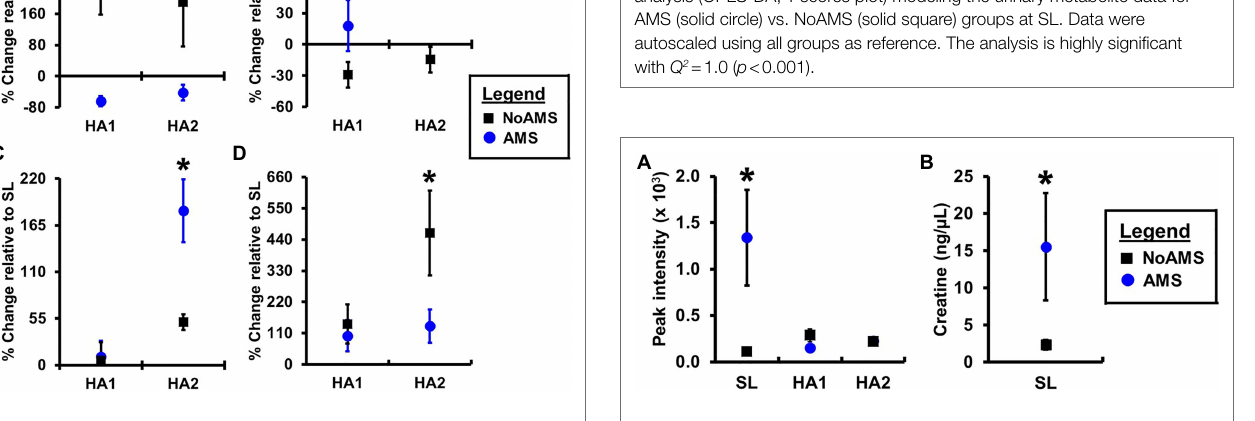
FIGURE 2 | Percent change in peak intensity of (A) creatine, (B) N-methylhistidine, (C) hypoxanthine, and (D) acetylcarnitine 4,300 m on day 1 (HA1) and day 18 (HA2) relative to SL for urine samples collected from AMS susceptible (blue symbol) and NoAMS resistant subjects (black symbol). Asterisk denotes significant difference between groups ( p ≤ 0.05).